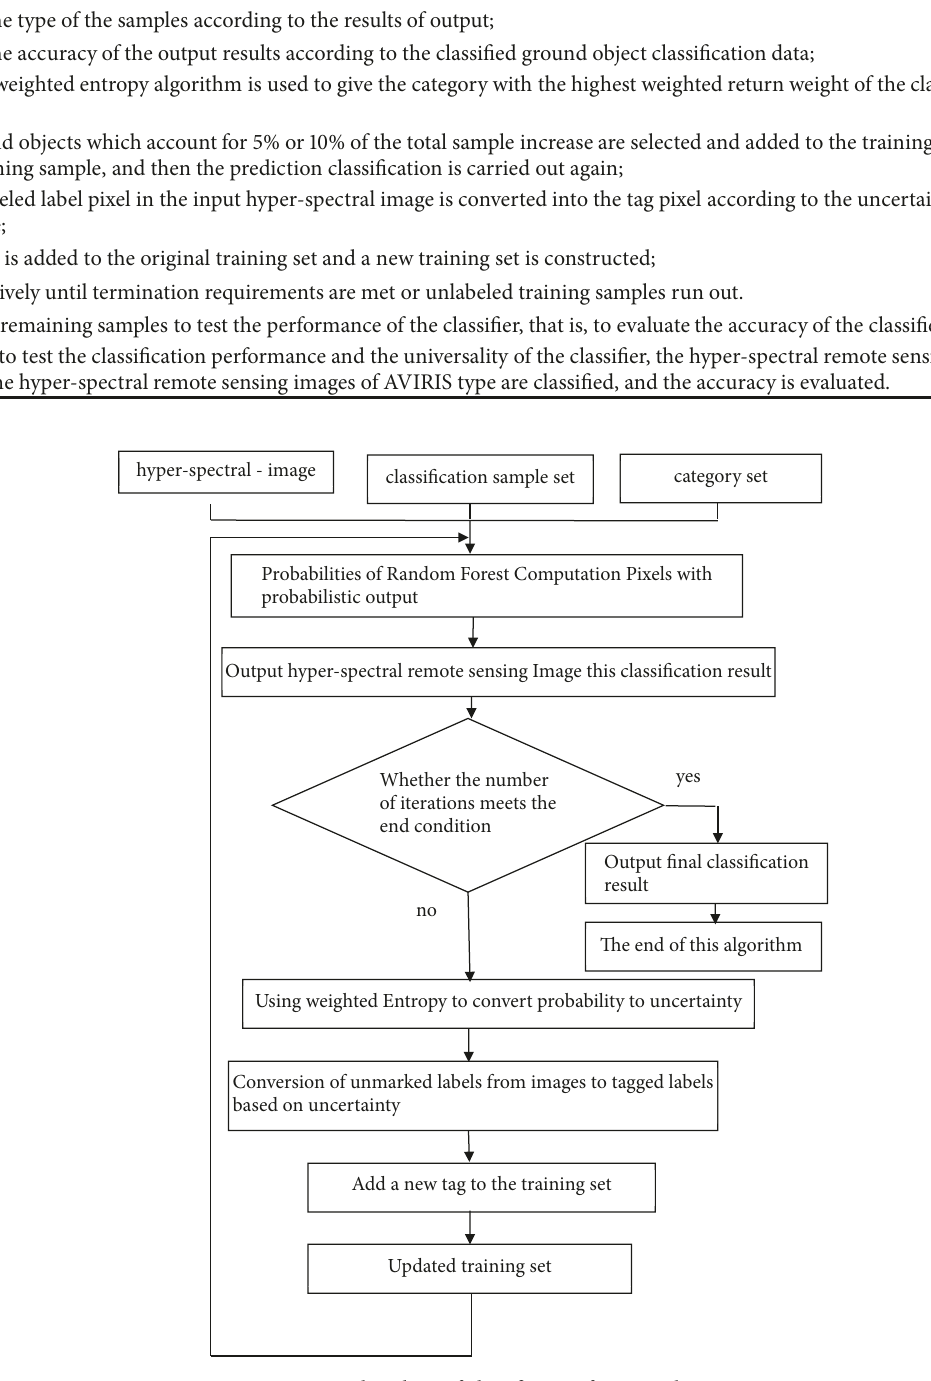
Figure 9: Flowchart of classification